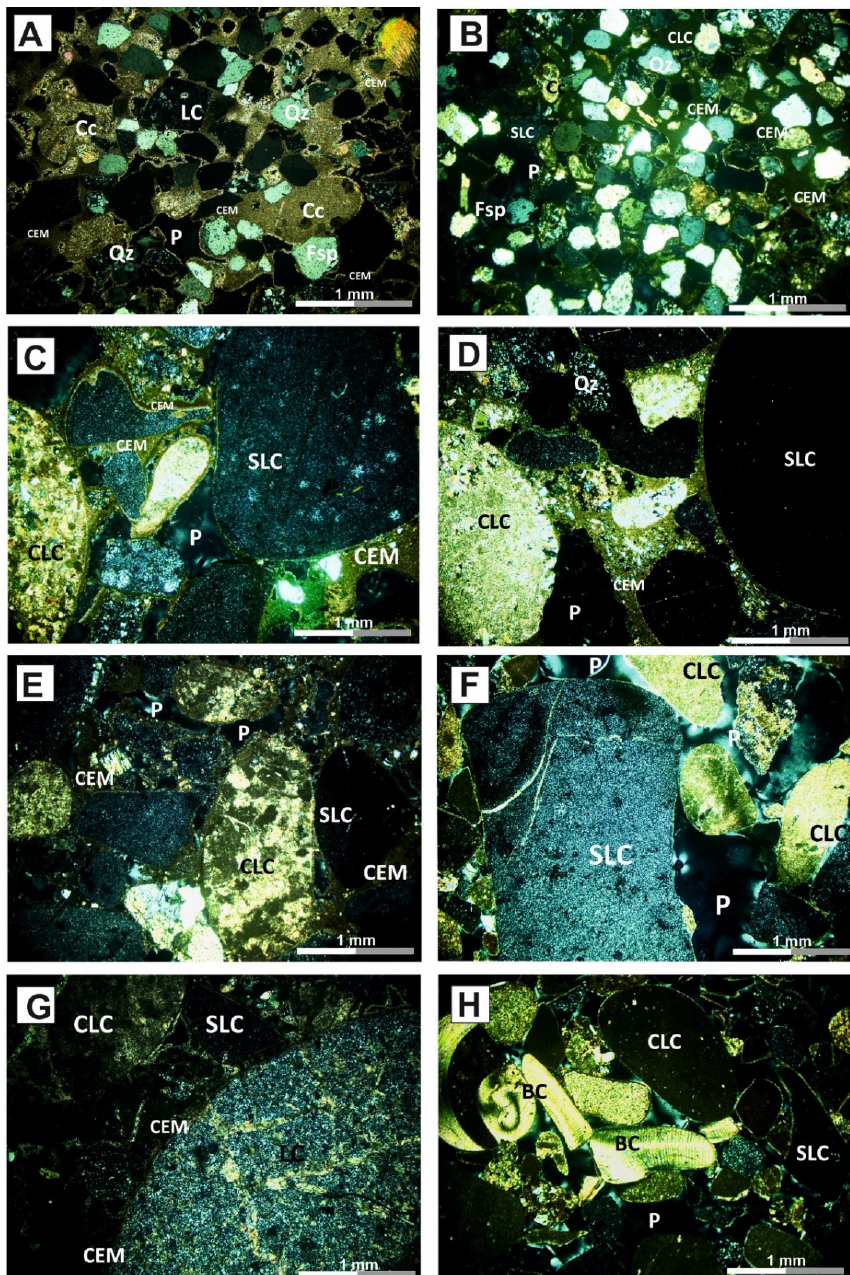
Figure 9. Photomicrographs of studied samples in cross polarized light (XPL). ( A ): Clastic texture in KAN1 sample. Sub-angular to sub-rounded grains or lithoclasts (fragments of cherts or limestones) cemented mainly by micritic material; ( B ): Micritic cement forms rims of grains and bridges or fills pores in the finer microstructure of KAN3 sample between the studied ones; ( C , D ): Grain textures of KAN2 and KAN2,1 samples. Note the high degree of grains roundness as well as the micro-channel porosity. Thin micritic rims usually coat the grains whilst cement form bridges too; ( E ): The medium grain sized sandstone of KAN2-3 sample; ( F , G ): Coarse textures of L1 and LY1 samples. Note the low amounts of cement (thin micritic rims around the grains) and the high porosity in L1 matrix. Higher amounts of peloid/micritic cement fills pores or coat the grains in LY1; ( H ): Presence of bioclasts in L1 sample; BC: bioclast (mollusk shell); CEM: cement; Cc: calcite; CLC: calcareous rich lithoclast; Fsp: feldspar; LC: lithoclast; P: pore; Qz: quartz, SLC: siliceous rich